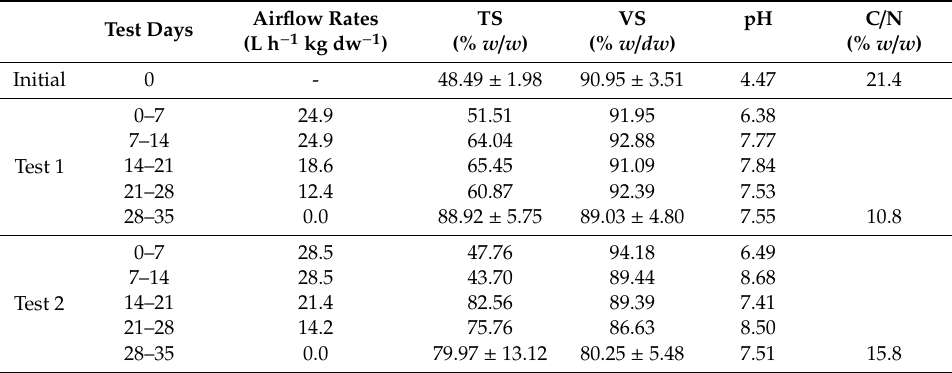
Figure 2. Scheme of the pilot-scale biodrying reactors. Table 1. Summary of the airflow rates and LF samples’ physicochemical characteristics.